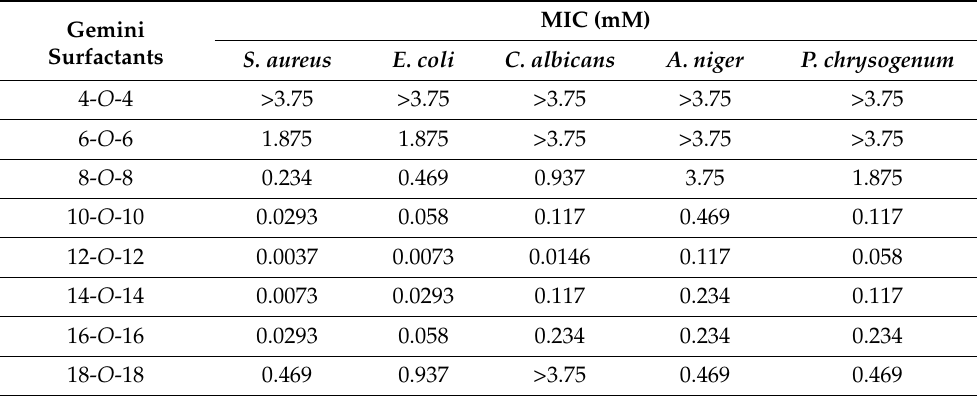
Table 4. MIC values (mM) for 3-oxa-1,5-pentane- bis ( N -alkyl- N , N -dimethylammonium